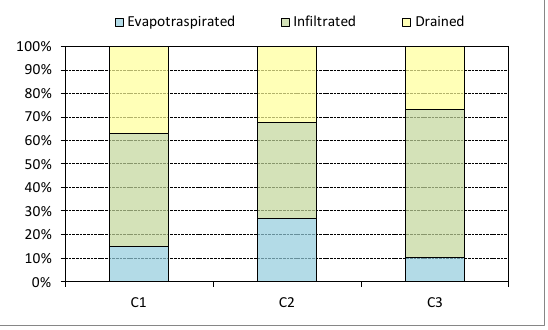
Figure 11. Graph related to the percentages of infiltrated, lost (due to evapotranspiration), and drained water with respect to rainfall, in cases C1, C2, and C3.